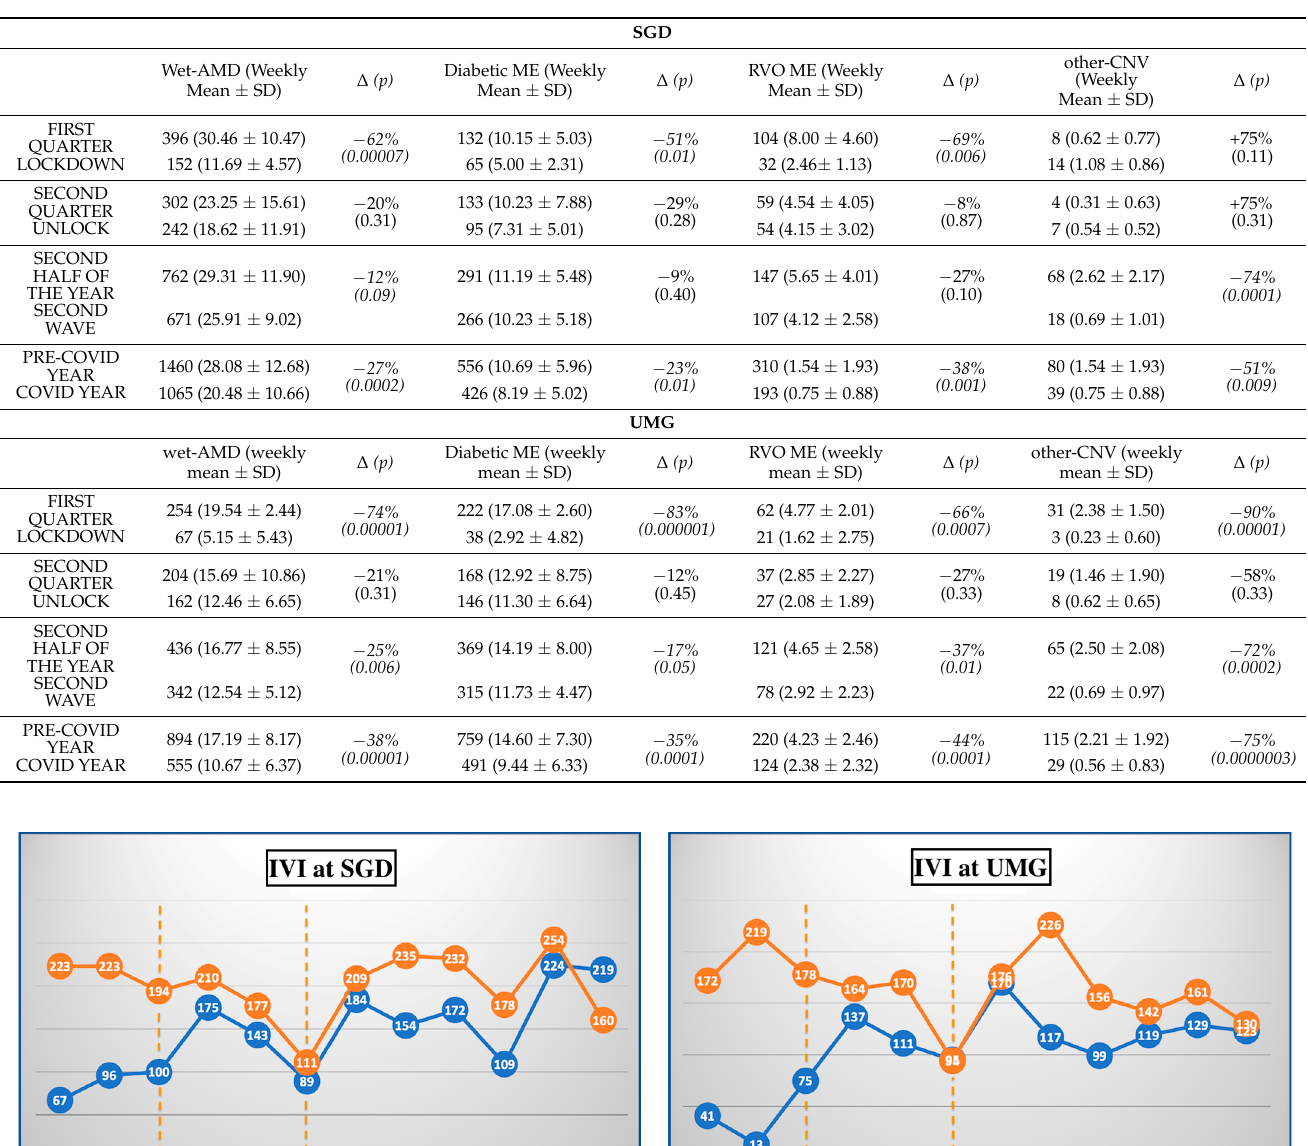
Table 2. Comparison of different retinal diseases treated at San Giovanni di Dio (SGD), University of Cagliari and Mater Domini, University Magna Græcia of Catanzaro (UMG). Note: statistically significant values are in italics.